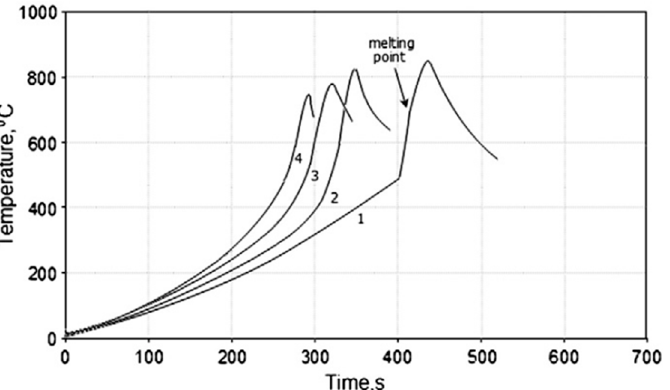
Figure 7. Thermograms of thermal explosion (TE) of a HEBM 3Ti+Al mixture. 1—1 min; 2—3 min; 3—5 min; 4—7 min of HEBM. Reprinted from [34], Copyright (2012), with permission from Elsevier.